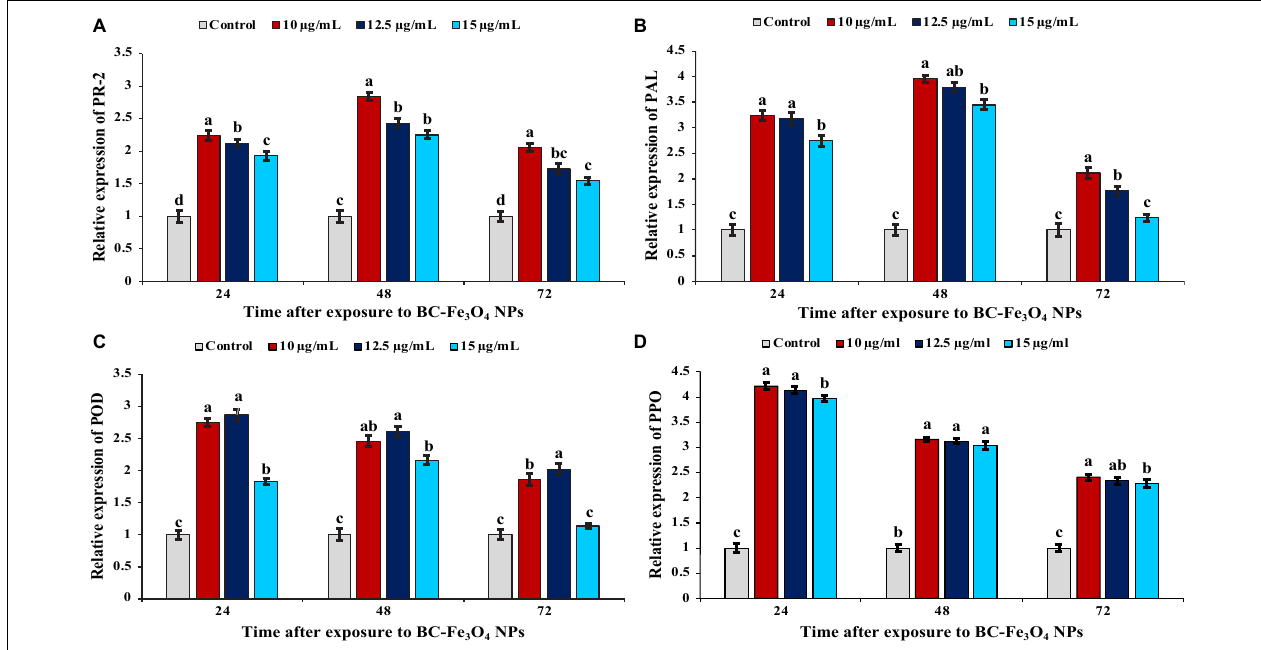
FIGURE 15 | Relative gene expression of pathogenesis-related protein and defense-related genes in tomato plants treated with 10, 12.5, and 15 µ g/ml of BC-Fe 3 O 4 NPs after second foliar spray harvested at 24, 48, and 72 h. (A) Expression level of PR-2, (B) expression level of PAL, (C) expression level of POD, and (D) expression level of PPO in tomato roots after treatment with BC-Fe 3 O 4 NPs. Vertical bars represent SD ( n = 3) between the mean of different replicates of the same treatment. Different letters per column indicate significant differences among treatments, determined by the ANOVA and LSD test at P ≤ 0.05.